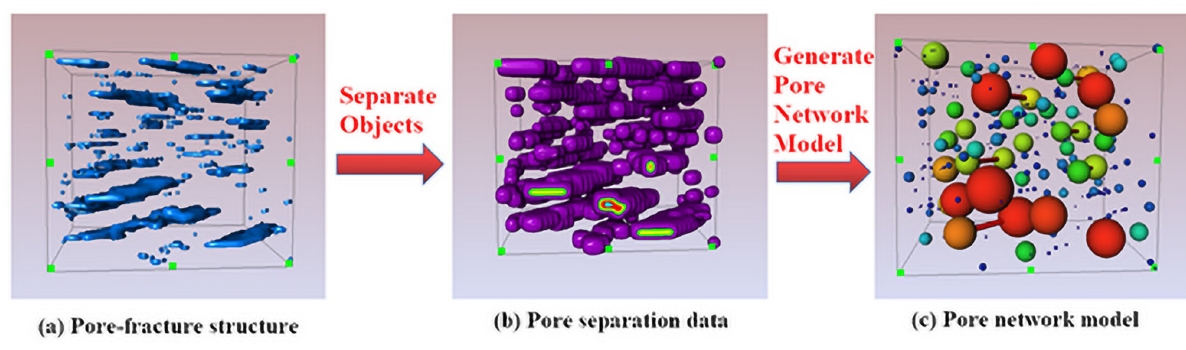
Fig 5. Analysis process from the pore model to ball-bat model.